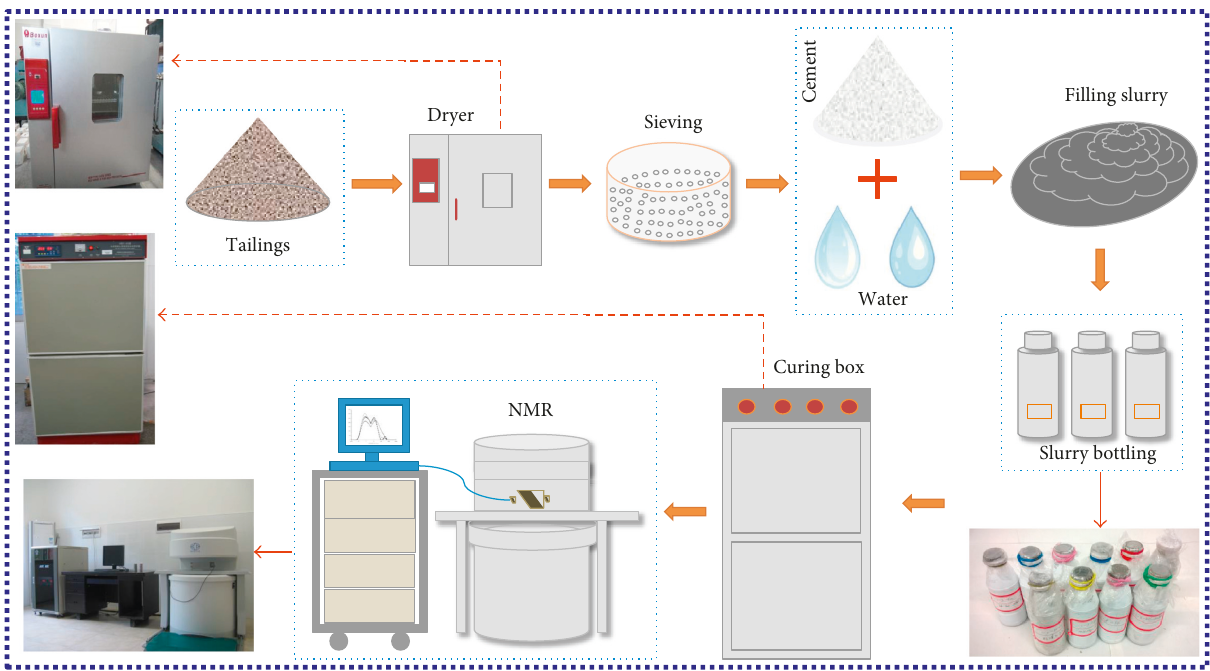
Figure 2: Experimental system and process.